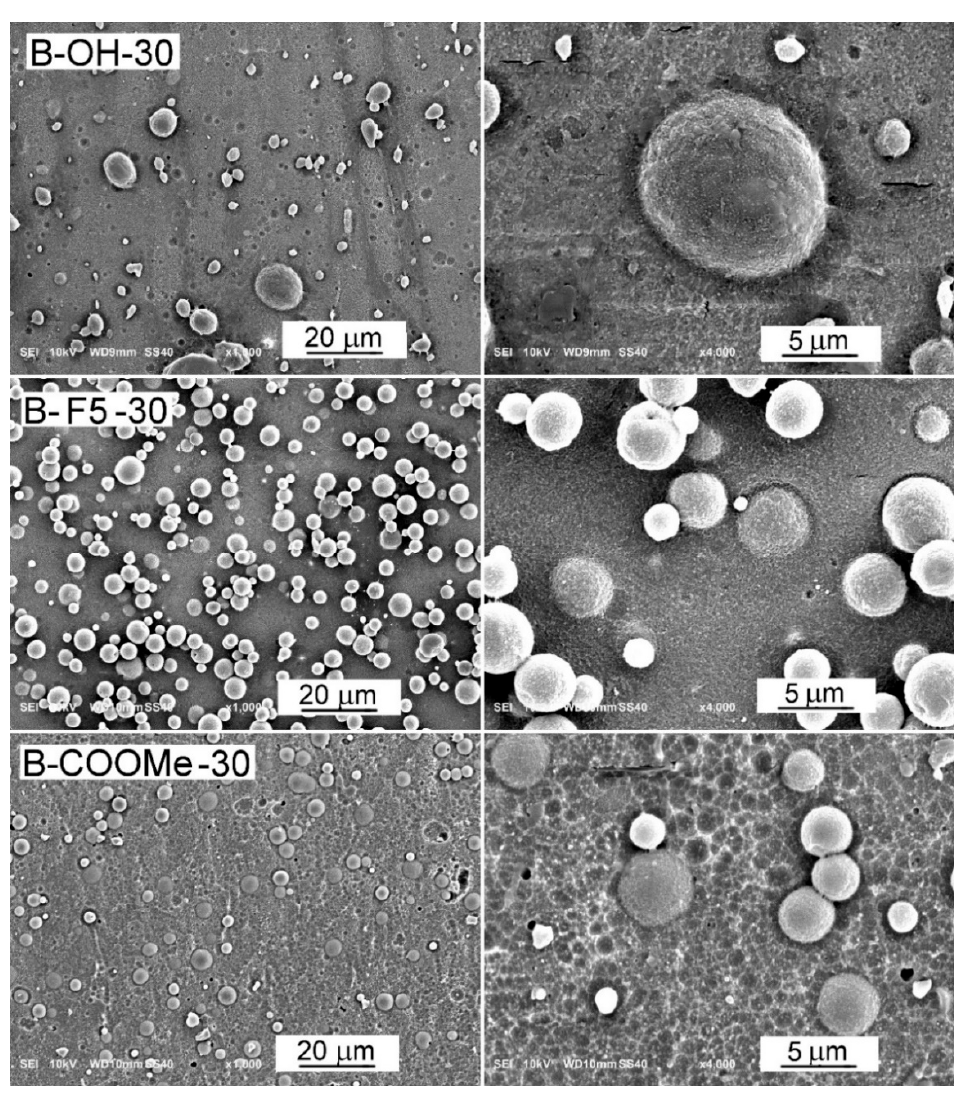
Figure 6. SEM micrographs of etched PLA/PMMA blends modified with 3 wt.% of LPSQ-R. Raman spectroscopy mapping was used to detect changes of concentration of